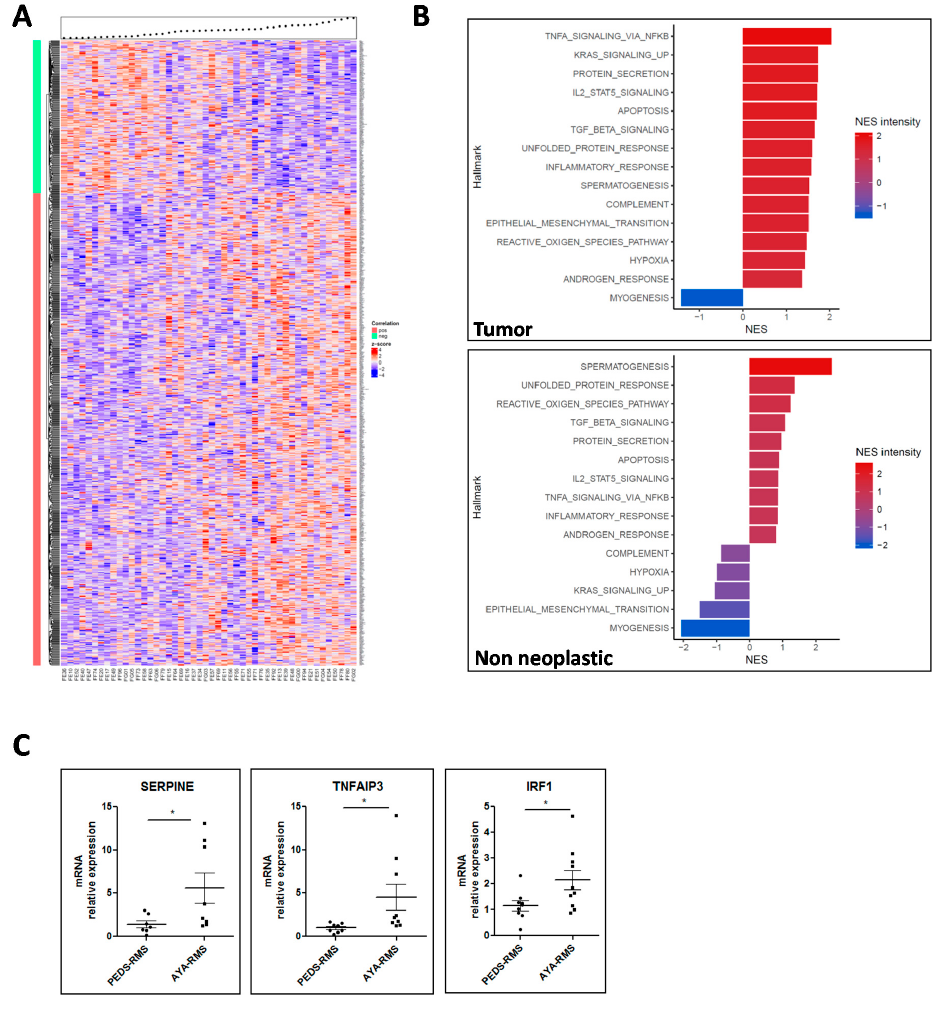
Figure 3. Gene expression modulation in AYA-RMS. ( A) Heatmap showing the expression of the age-correlated genes according to Spearman’s rank correlation test for tumor samples sorted by age (the black dots above the heatmap). Genes corresponding to the red vertical bar are positively correlated (n = 793) while those associated to the green bar are negatively correlated (n = 194). (B) GSEA analysis revealed pathways enrichment according to age in tumor (upper image) and non-neoplastic tissues (lower image). (C) Real Time graphs show upregulation of SERPINE, TNFAIP3 and IRF1 in AYA-RMS (n = 10 for each group). Data are expressed as mean ± SEM. * p < 0.05.